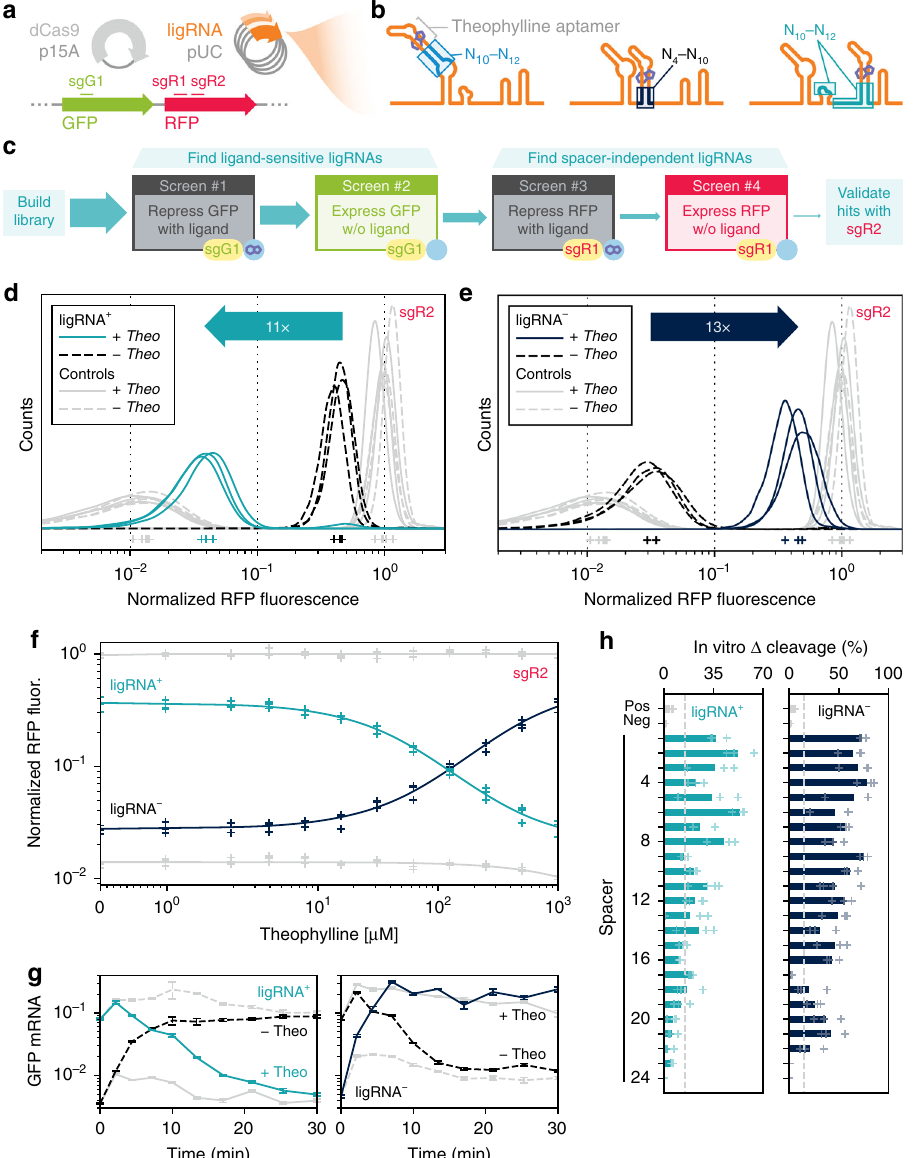
Fig. 2 Identi fi cation of robust ligRNAs using CRISPRi-based gene repression in E. coli . a Components used in the CRISPRi assay. dCas9 and any ligRNAs were expressed from plasmids, while the fl uorescent reporters (GFP and RFP) were chromosomally integrated. The DNA regions targeted by different spacers (sgG1, sgR1, sgR2) used to repress the fl uorescent reporters are indicated. b Regions randomized in each ligRNA library. c Schematic of the screen used to isolate ligRNA + . sgG1, sgR1, and sgR2 refer to spacers targeting GFP and RFP, respectively (Supplementary Table 4). d , e Single-cell RFP fl uorescence distributions for ligRNA + (teal, d ) and ligRNA − (navy, e ) targeting RFP using the sgR2 spacer with (solid lines) and without (dashed lines) theophylline. Control distributions are in grey (positive control: optimized sgRNA scaffold; 51 negative control: G43C G44C 28 ). The mode of each distribution is indicated with a plus sign. RFP fl uorescence values for each cell are normalized by both GFP fl uorescence for that cell and the modes of the un-repressed control populations (i.e. apo and holo ) measured for that replicate. f Ef fi ciency of CRISPRi repression with increasing theophylline concentrations for ligRNA + (teal) and ligRNA − (navy). Controls are in grey. The fl uorescence axis is the same as in d and e . The fi ts are to a two-state equilibrium model. g GFP mRNA levels after the addition or removal of theophylline. GFP mRNA levels were measured by qPCR and are normalized to 16S rRNA levels. Solid, colored lines: theophylline added at t = 0. Black, dashed lines: theophylline removed at t = 0. Grey lines: theophylline present (solid) or absent (dashed) for the whole experiment. Error bars re fl ect standard deviations from 3 technical replicates. h Change in the percentage of DNA cleaved in vitro in the presence and absence of theophylline for ligRNA + and ligRNA − for 24 representative spacers. Bar heights represent the mean of three or four measurements with a single spacer (except for spacer #24, where n = 2, Supplementary Table 5). Data for each replicate are shown as faded plus marks. Pos and Neg denote the positive and negative control sgRNA scaffolds (Supplementary Table 4). The control bars